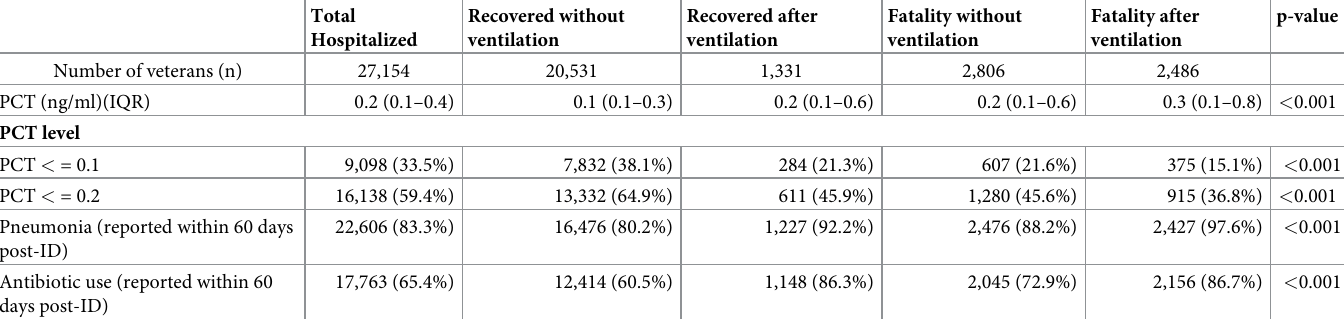
Table 3. Reported cases of pneumonia and antibiotic use within the study cohort of 27,154 COVID-19-positive US veterans.